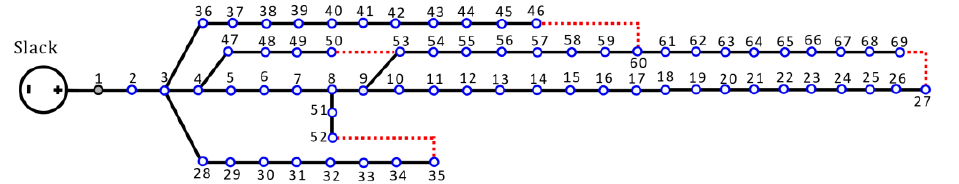
Figure 3. Modified 69-node LVDC test feeder [3,4].